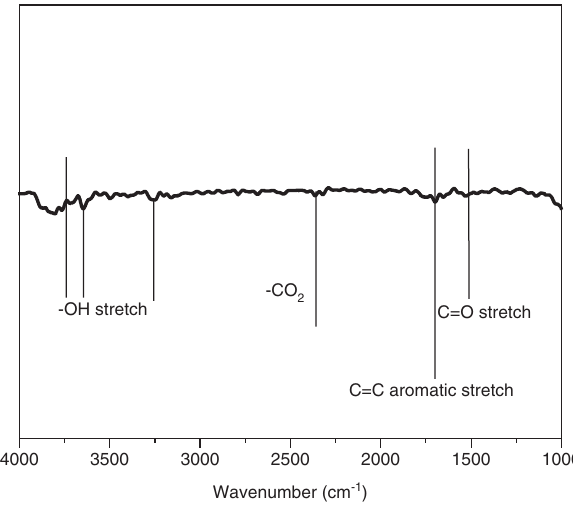
Figure 5 FTIR spectra of Fe-RF-AG.